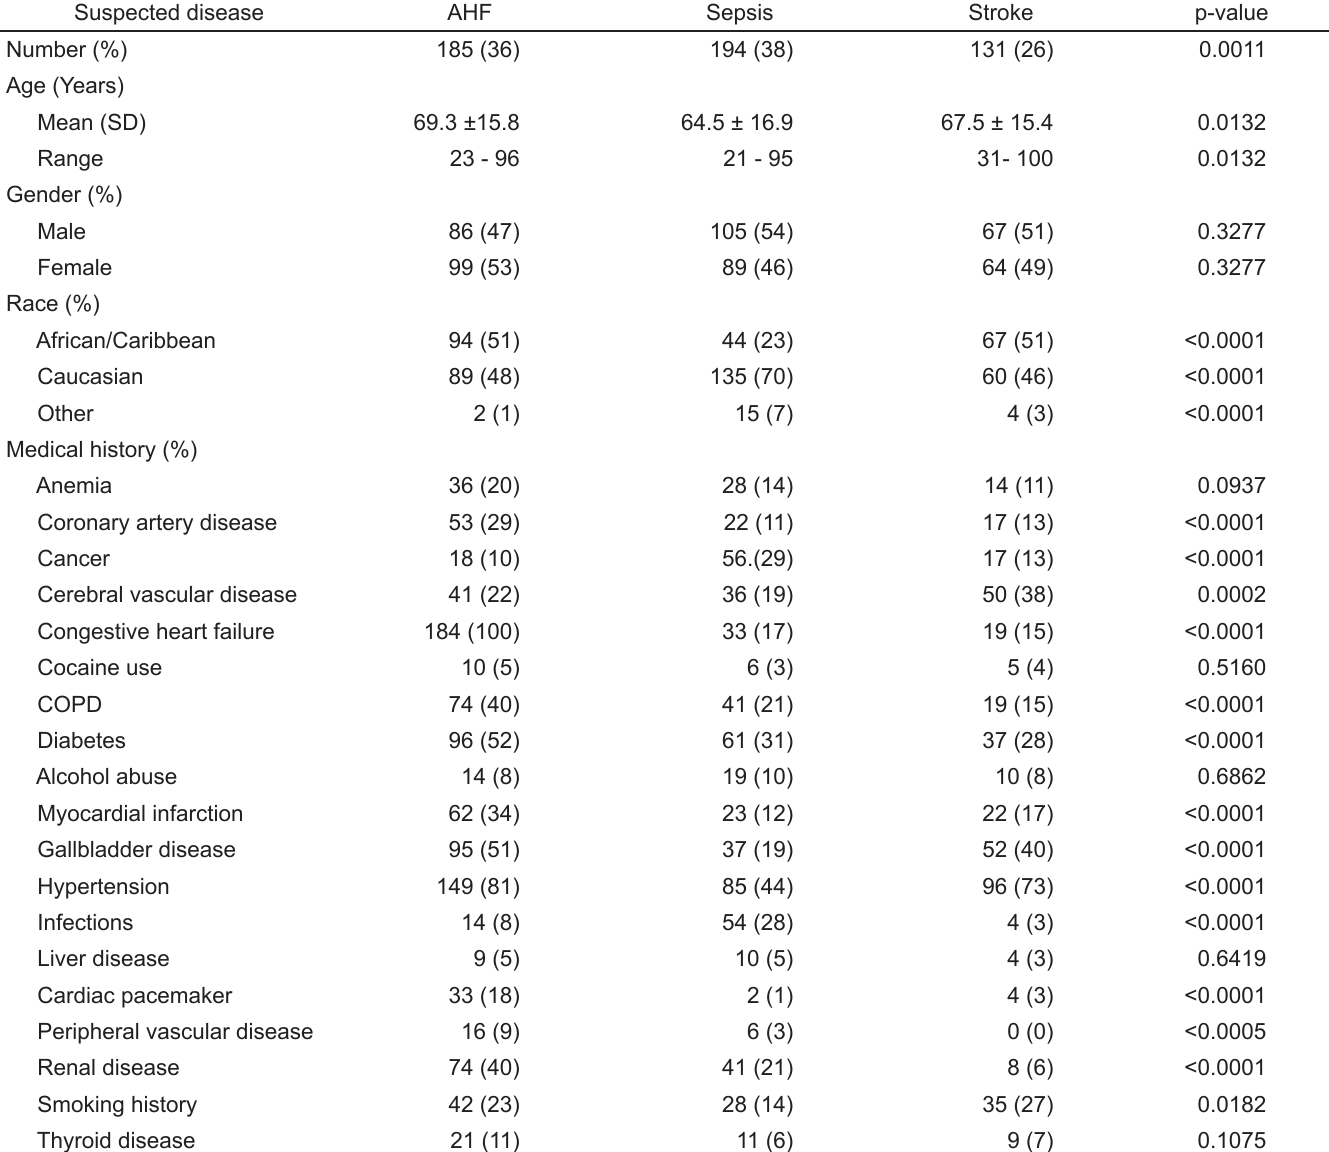
Table 1. Baseline characteristics of patients